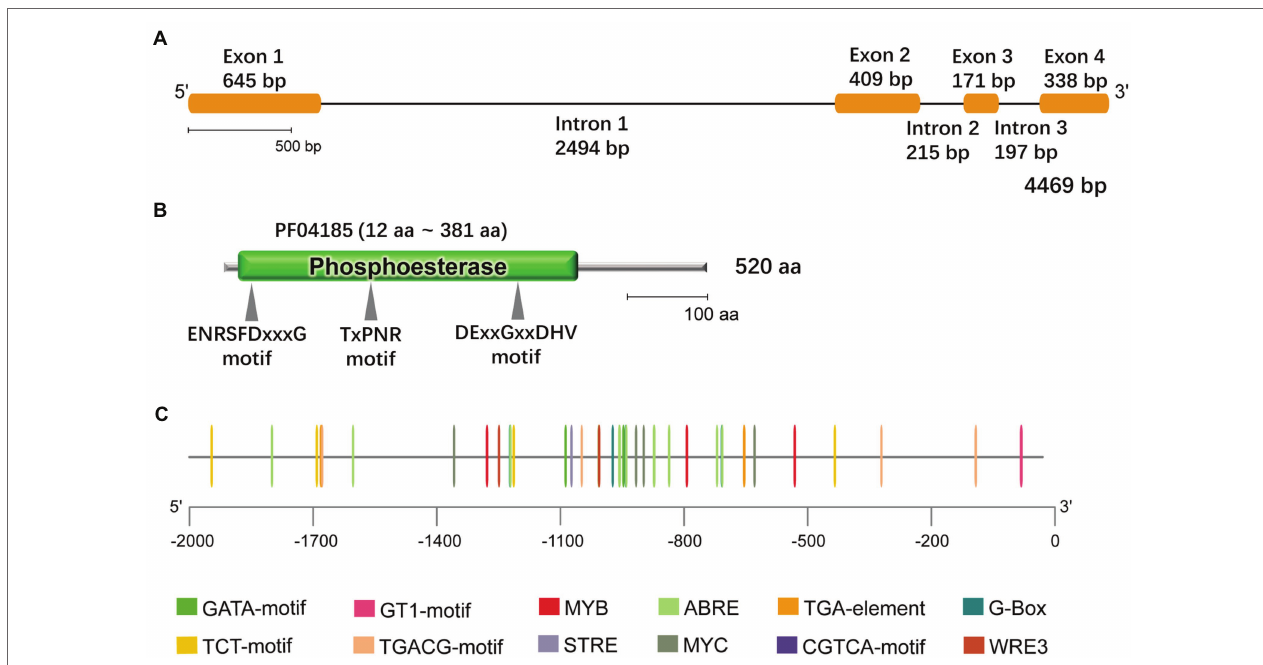
FIGURE 1 | Bioinformatics features of GlNPC3 . (A) GlNPC3 exons and introns obtained through GSDS V2.0. The yellow rectangles represent exons, and the black lines represent introns. (B) Schematic representation of the GlNPC3 protein; the phosphoesterase domain (Pfam entry PF04185) and conserved domains are indicated. (C) Plant regulatory elements in the GlNPC3 promoter region were obtained from the PlantCARE